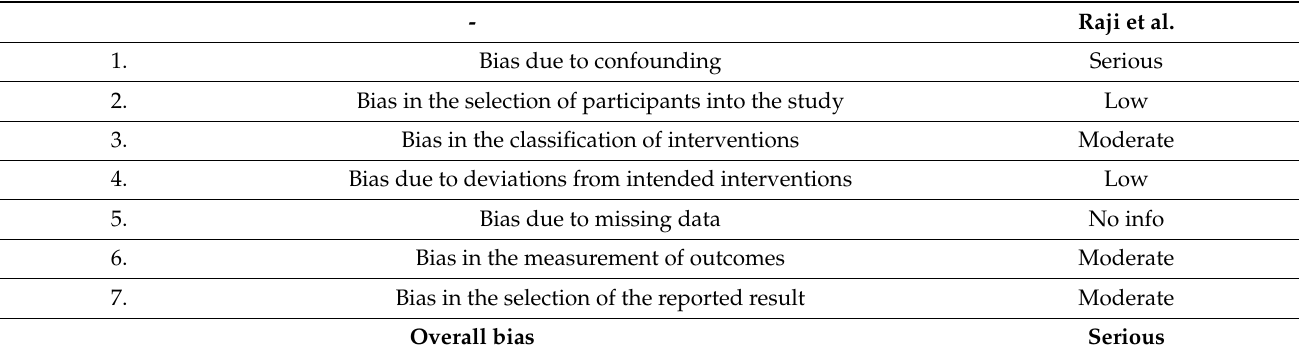
Table 2. The quality analysis of controlled clinical trials using ROBINS-I tool.